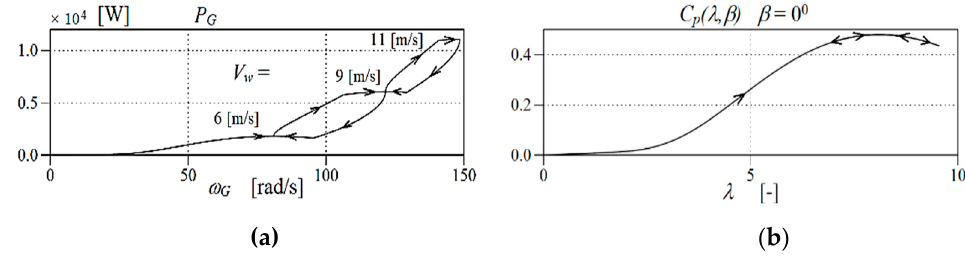
Figure 11. Waveforms of generator power P G ( a ) and turbine power coefficient C p ( λ , β ) ( b ) for changing wind speed V w and blade angle equal to β = 0°.